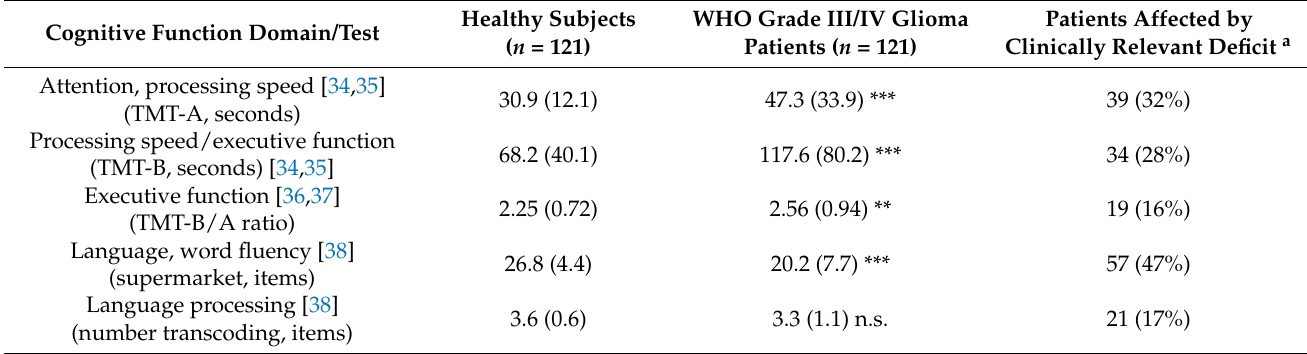
Table 1. Cognitive test scores in Grade III/IV glioma